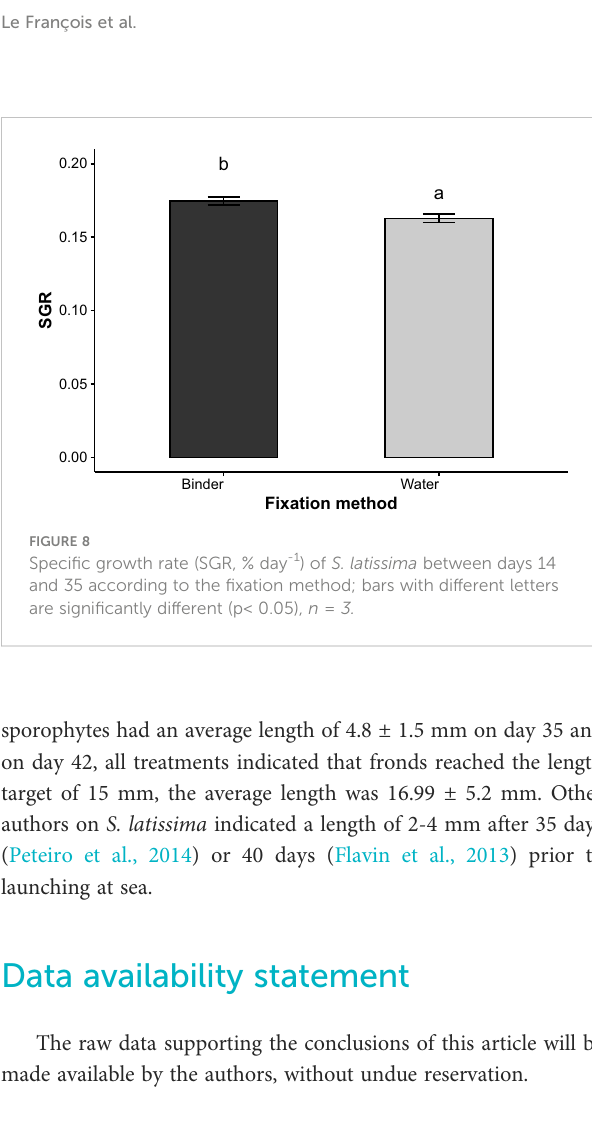
Le Franc ¸ ois et